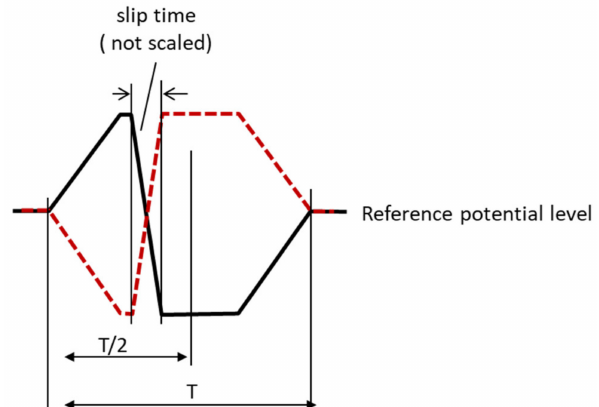
Figure 2. Idealized mirrored and truncated sawtooth signal waveforms to drive the two-phase inertia-type motor (T is the period). When the multilayer actuators are exposed to these waveforms, as one actuator expands, the other shrinks